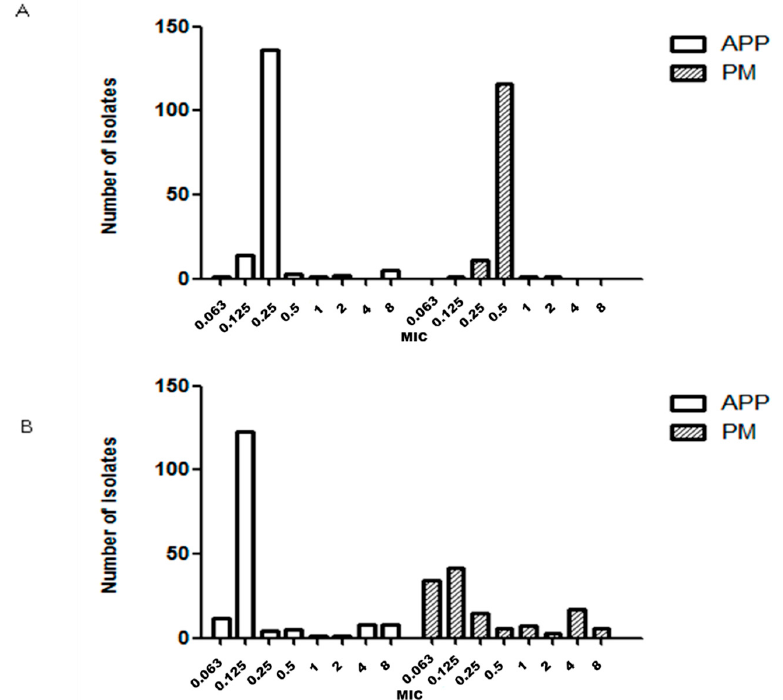
Figure 2. Minimum inhibitory concentration (MIC, µ g / mL) distribution of enrofloxacin ( A ) and doxycycline ( B ) for Actinobacillus pleuropneumoniae (APP) and Pasteurella multocida (PM) isolated from lungs of pigs with respiratory symptoms.